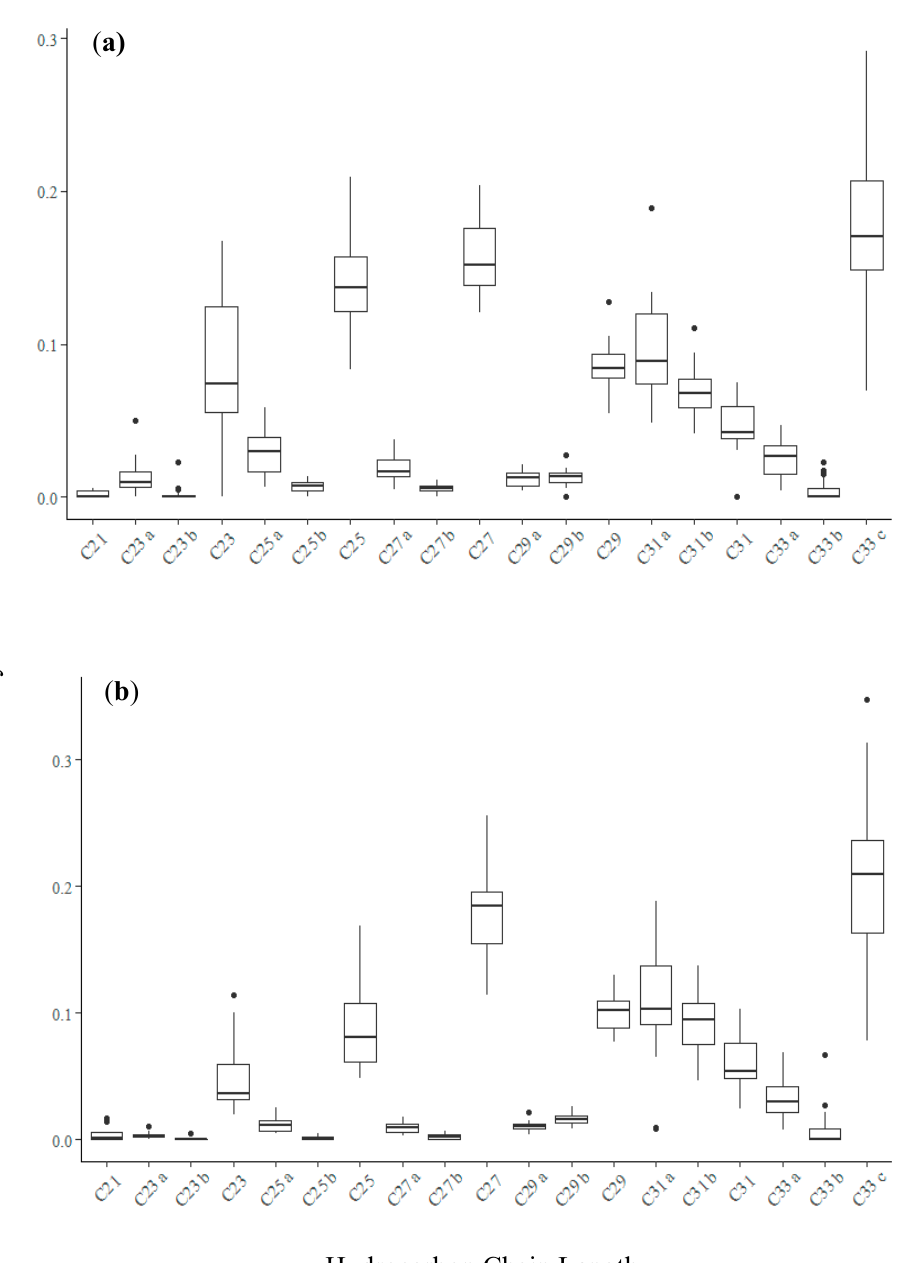
Figure 3. Box and whisker plots illustrating the relative abundance of hydrocarbons for all samples collected from ( a ) the entrance and ( b ) in-cover of hives. Boxes contain the interquartile range—50% of data—with center line indicating the median value of data. Whiskers indicate minimum and maximum values within 1.5 times above the 75th percentile or below the 25th percentile, with dots representing outliers.